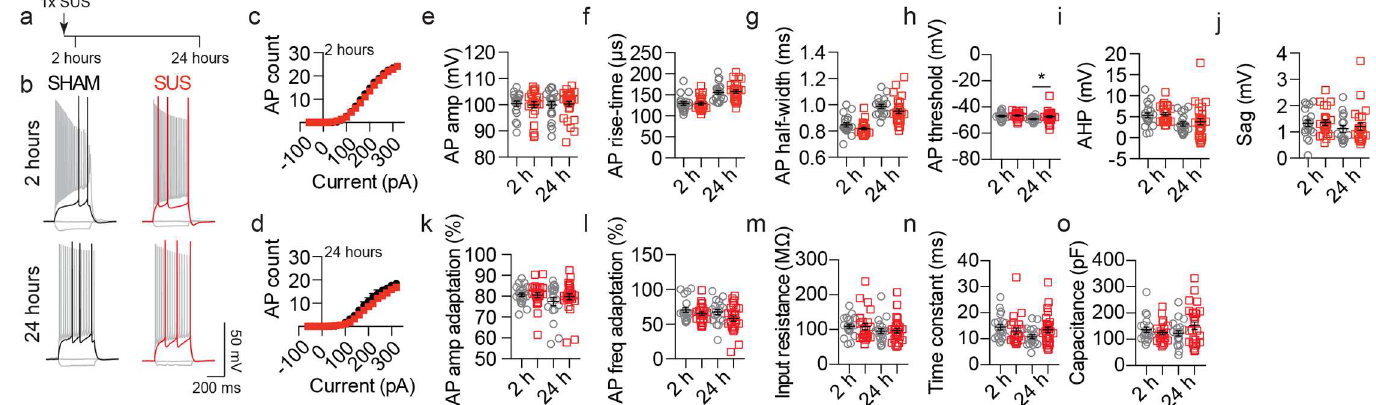
Fig 2. A single SUS treatment does not alter CA1 pyramidal neuronal excitability at short time-points. (a) Overview of the experimental design of the single SUS/sham treatment. Arrows indicate number of treatments. (b) Representative traces of APs generated by injectionof current steps (-60, 0, threshold and 320 pA). (c, d) Input-output relationships from neuronsin sham- (black circles) and SUS-treated mice (red squares) recorded(c) 2 hours (2 h, p = 0.56, SUS 171.1 ± 13.7 a.u., sham 180.4 ± 13.8 a.u.) or (d) 24 hours (24 h, p = 0.33, SUS 109.9 ± 10.6 a.u., sham 132.6 ± 14.6 a.u.) followinga single treatment. Quantification of (e) AP amplitude(2 h, p = 0.93, SUS 99.98 ± 1.2 mV, sham 100.4 ± 0.98 mV; 24 h, p = 0.89, SUS 100.3 ± 0.99 mV, sham 99.99 ± 1.3 mV), (f) rise-time (2 h, p = 0.89, SUS 129.5 ± 3.5 μ s, sham 129.4 ± 4.1 μ s; 24 h, p = 0.58, SUS 158.1 ± 3.90 μ s, sham 155.8 ± 4.61 μ s), (g) half- width (2 h, p = 0.09, SUS 0.82 ± 0.01 ms, sham 0.85 ± 0.02 ms; 24 h, p = 0.06, SUS 0.95 ± 0.02 ms, sham 0.99 ± 0.01 ms), (h) AP threshold(2 h, p = 0.42, SUS -46.4 ± 0.53 mV, sham -47.0 ± 0.63 mV; 24 h, p = 0.0147, SUS -47.5 ± 0.82, sham -49.2 ± 0.4 mV) ( i ) AHP (2 h, p = 0.82, SUS 5.6 ± 0.42 mV, sham 5.3 ± 0.58 mV; 24 h, p = 0.80, SUS 4.1 ± 0.86 mV, sham 3.6 ± 0.57 mV), (i) sag (2 h, p = 0.93, SUS 1.36 ± 0.11 mV, sham 1.33 ± 0.12 mV; 24 h, p = 0.75, SUS 1.2 ± 0.14 mV, sham 1.1 ± 0.13 mV), (k) AP amplitudeadaptation (2 h, p = 0.84, SUS 80.57 ± 1.23%, sham 80.7 ± 0.90%; 24 h, p = 0.39, SUS 89.2 ± 1.48%, sham 77.5 ± 1.95%), (l) AP frequencyadaptation(2 h, p = 0.30, SUS 65.1 ± 2.67%, sham 70.7 ± 3.49%; 24 h, p = 0.10, SUS 58.1 ± 3.83%, sham 67.4 ± 3.81%), (m) input resistance (2 h, p = 0.39, SUS 109.2 ± 9.3 M Ω , sham 109.8 ± 6.2 M Ω ; 24 h, p = 0.89, SUS 96.87 ± 6.5 M Ω , sham 95.5 ± 7.3 M Ω ), (n) time constant (2 h, p = 0.14, SUS 13.02 ± 1.2 ms, sham 14.5 ± 1.0 ms; 24 h, p = 0.11, SUS 13.45 ± 1.1 ms, sham 10.81 ± 0.75 ms) and (o) capacitance (2 h, p = 0.43, SUS 124.4 ± 7.91 pF, sham 136.3 ± 10.42 pF; 24 h, p = 0.22, SUS 151.7 ± 13.94 pF, sham 122.7 ± 10.62 pF). Data are presented as mean ± SEM and as individualdata points. * p < 0.05. Sample size: 2 hour time-point—SUS n = 23 neurons and sham n = 20 neurons. 24 hour time-point —SUS n = 28 neuronsand sham n = 20